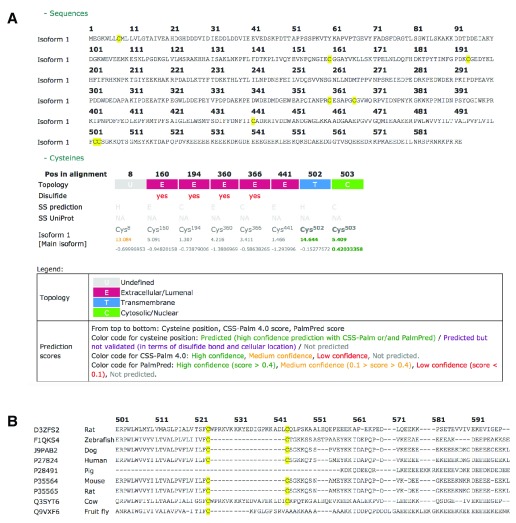
Additional information.
A: (upper) Global alignment of isoform sequences highlighting all cysteine residues. (lower) When available, information on protein topology, disulfide bond involvement and prediction scores from CSS-Palm 4.0 and PalmPred are provided for each cysteine residue in the different isoform sequences.
B: Global alignment of orthologs sequences show conserved cysteine residues (502 and 503 in human calnexin) across species.